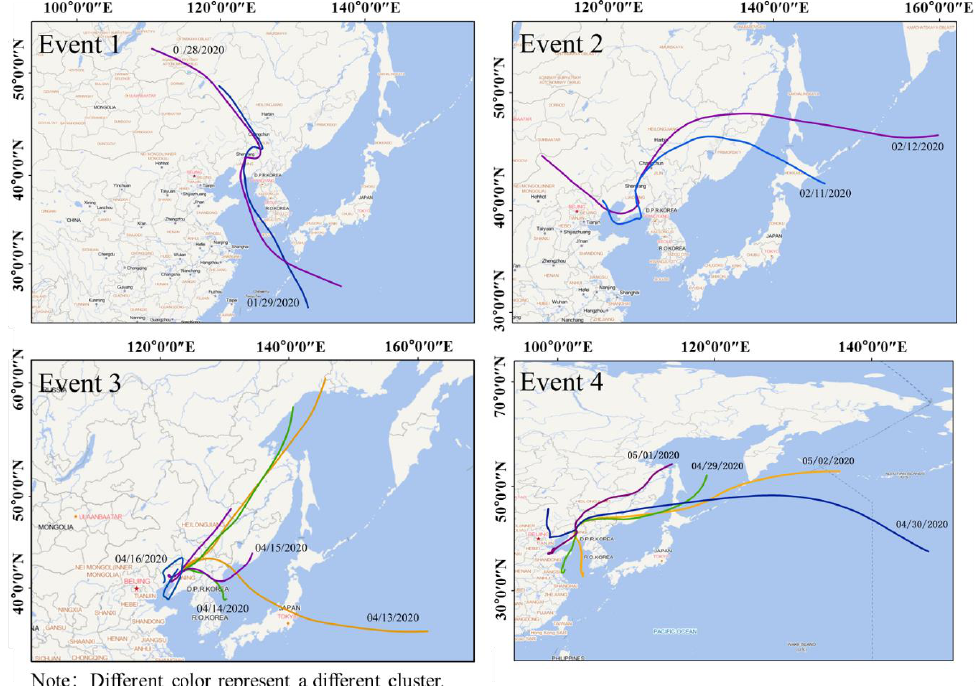
Figure 8. Transmission channels of pollution events 1 – 4 in Shenyang in the first half of 2020.